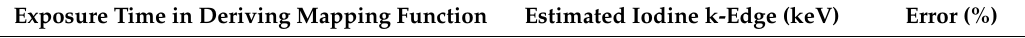
Table 2. Iodine k-edge energies estimated from the mapping functions derived with different exposure